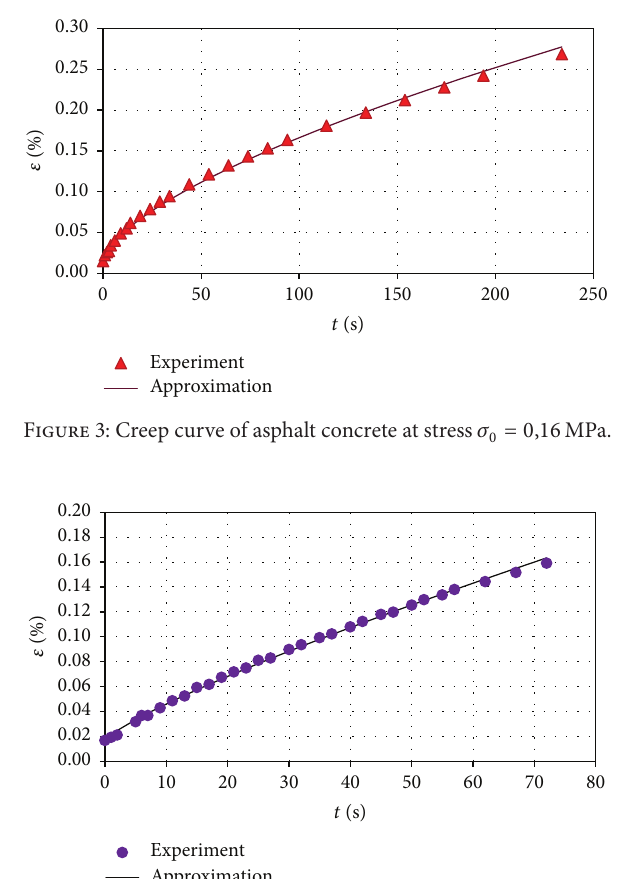
𝜀 = 0 , 015217 % and 𝛼 = 0 , 35 at 𝜎 0 0 , 016871 % and 𝛼 = 0 , 18 at 𝜎